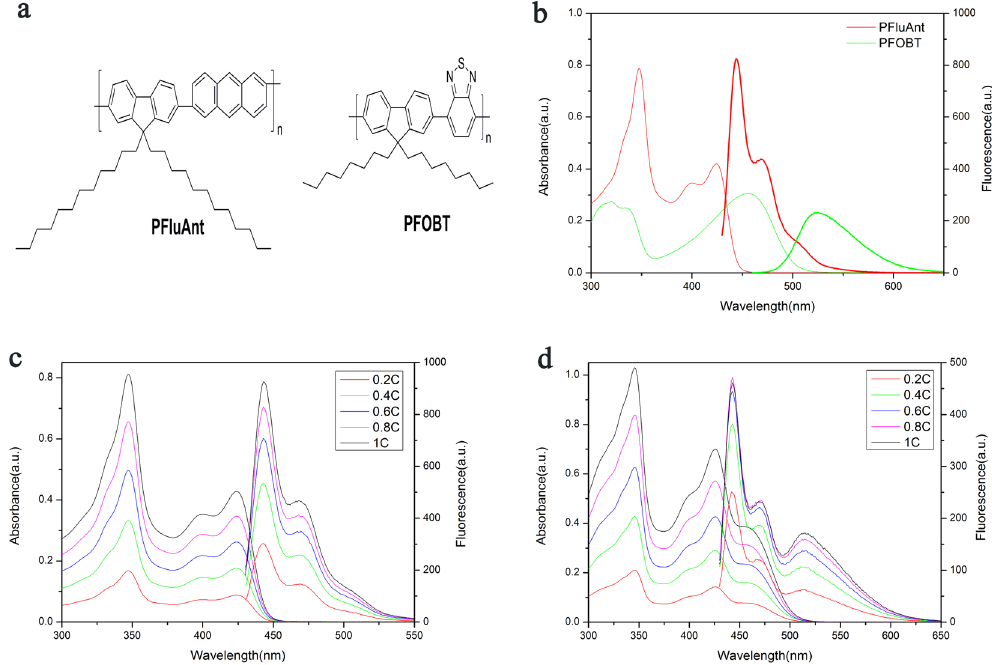
Figure 1. Chemical structures and optical properties of PFluAnt solution and PFluAnt&PFOBT mixture. ( a ) Chemical structures of fluorescent polymers (PFluAnt and PFOBT) used in this study. ( b ) UV-Vis and Fluorescence spectra of PFluAnt and PFOBT solution. ( c ) concentration dependence of UV-Vis absorption and fluorescence spectra of PFluAnt solution. ( d ) concentration dependence of UV-Vis absorption and fluorescence spectra of PFluAnt &PFOBT mixture